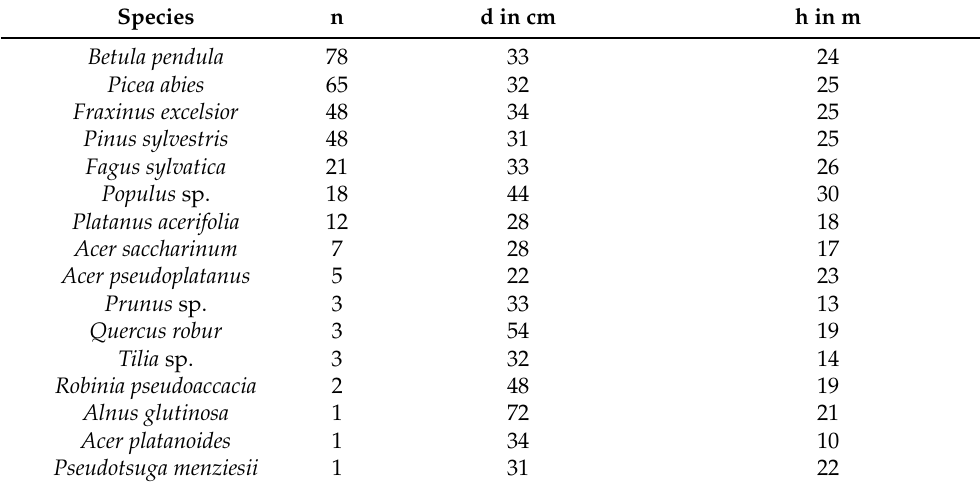
Table 1. Tree species and average tree sizes used in the